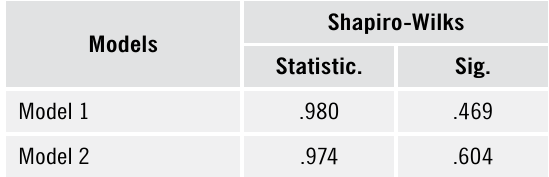
Table 7. Normality test